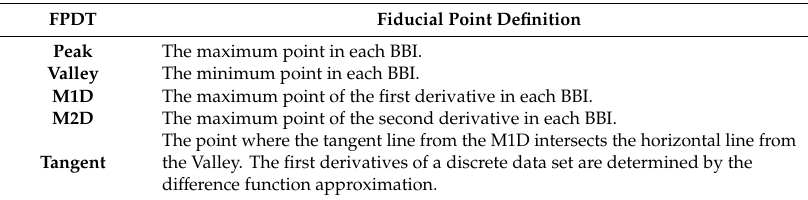
Table 2. Definitions of fiducial point detection techniques